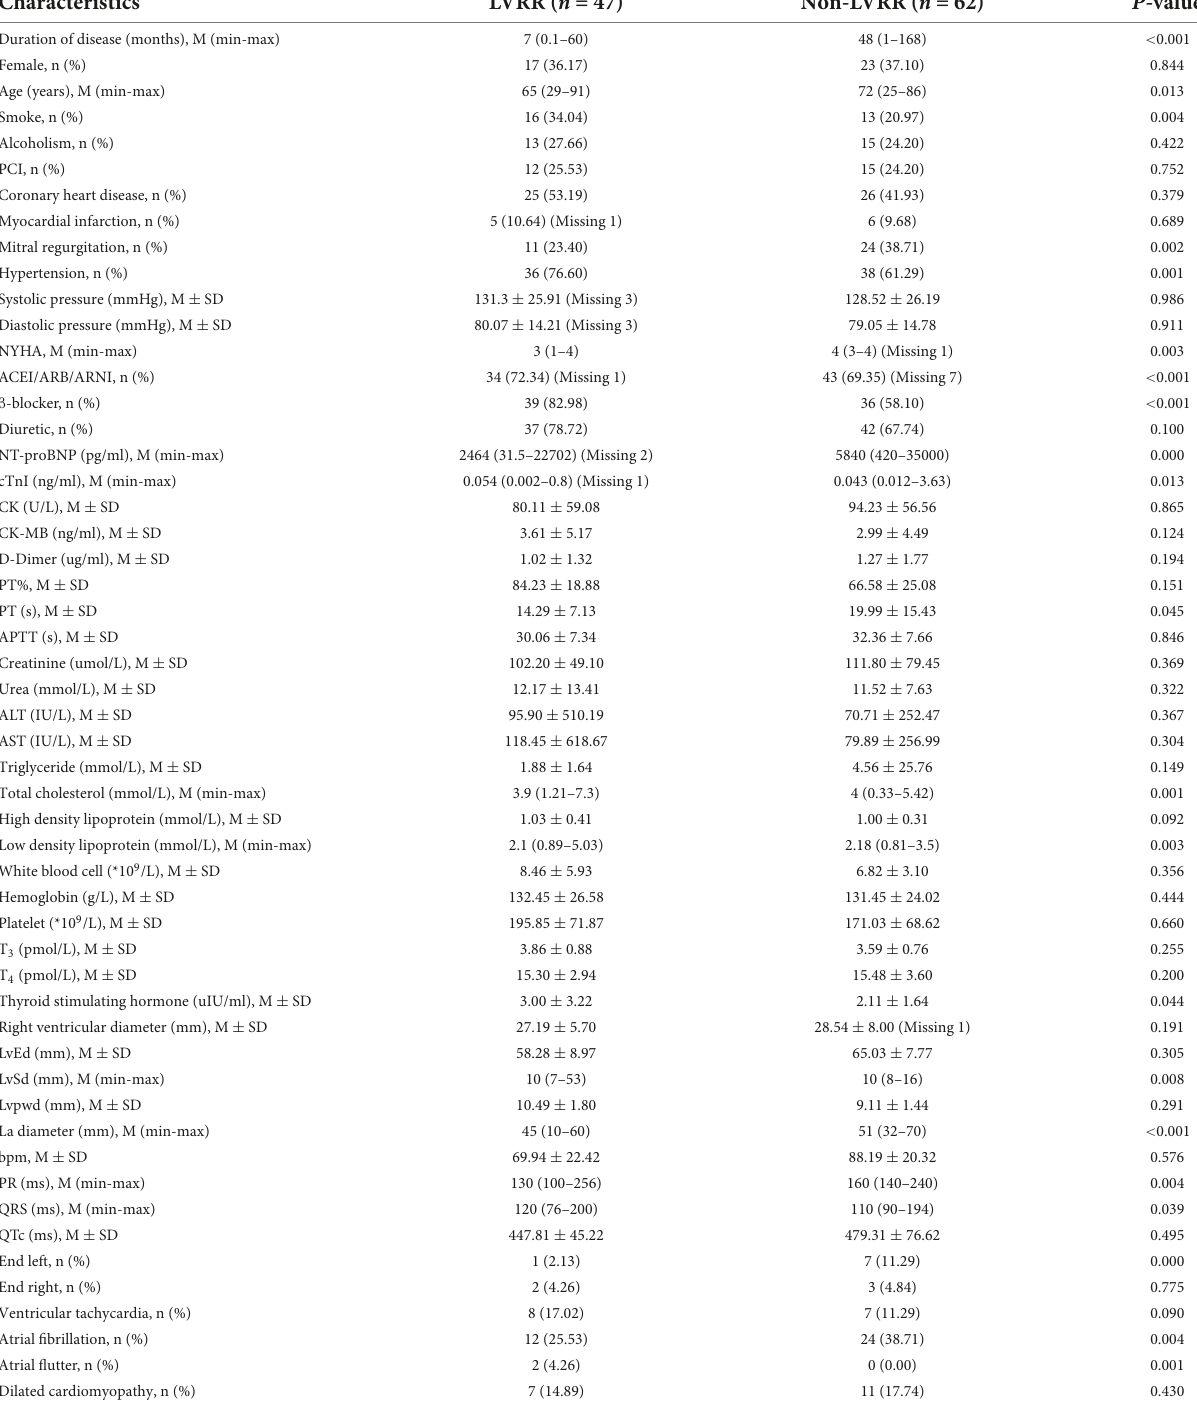
TABLE 1 Characteristics of patients grouped by left ventricular reverse remodeling.